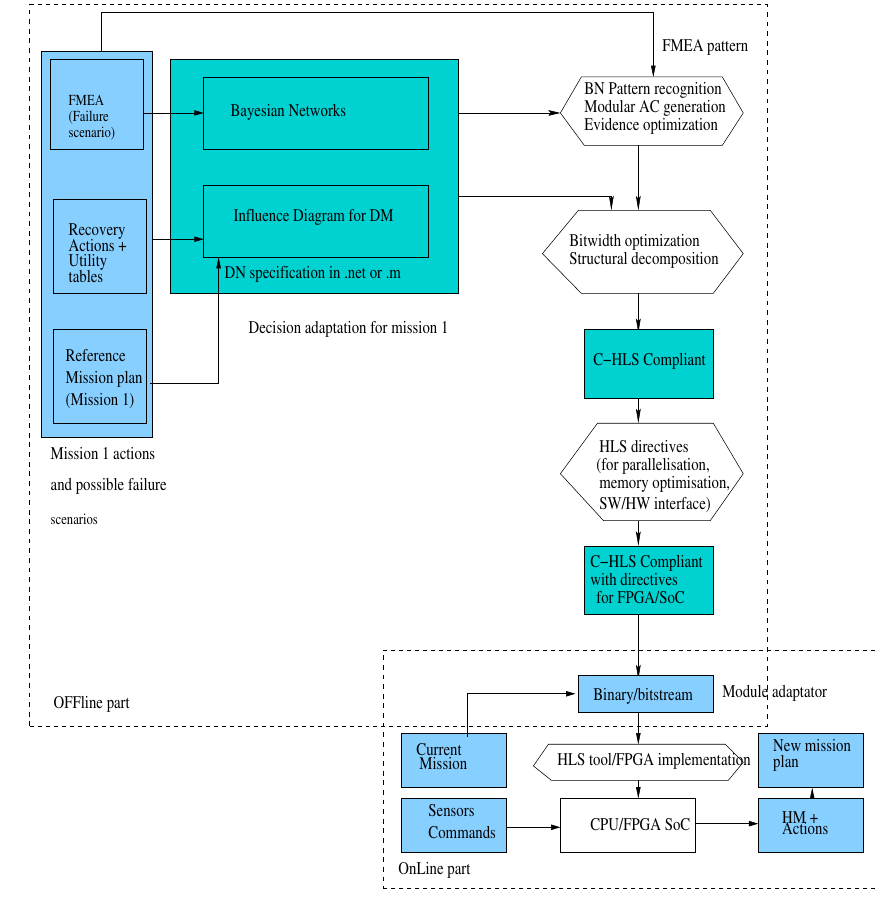
Figure 16. HLS design tool proposal for Decision Networks onto FPGA SoC